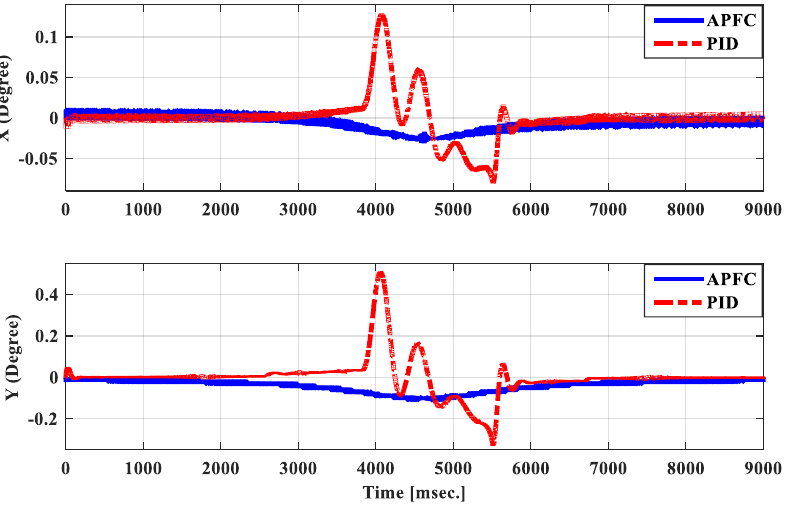
Figure 5. Tracking error of X-Y pedestal system in 𝑋 and 𝑌 axes for APFC scheme and PID con- troller.